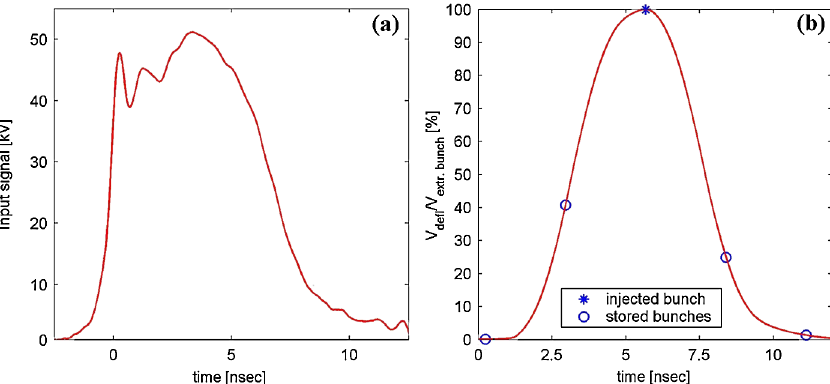
kicker.FIG. 8. (a) High voltage input pulse and related total deflecting field seen by bunches as a function of time arrival in the kicker structure